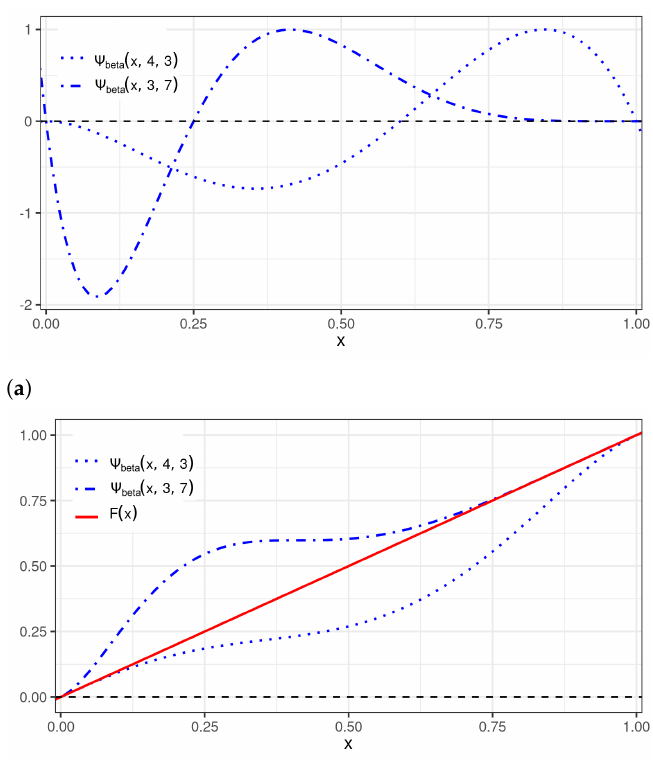
Figure 3. Plots of: ( a ) beta wavelet perturbations to be applied to the U [ 0,1 ] distribution; and ( b ) ψ beta ( x ,4,3 ) perturbed uniform ( · · · blue), ψ beta ( x ,3,7 ) perturbed uniform (- · - blue), and uniform (— red) CDFs.